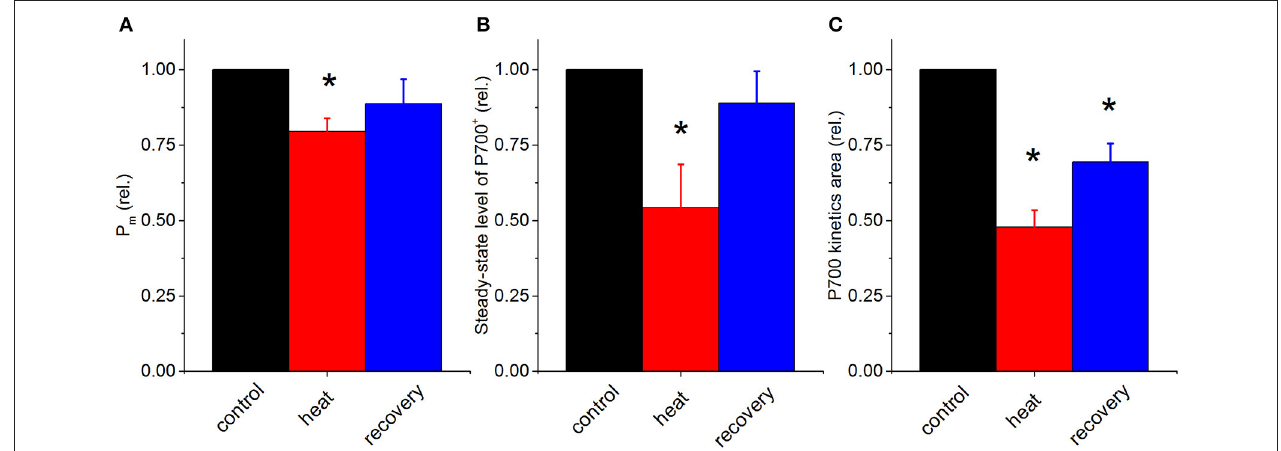
FIGURE 2 | Relative changes in P700 parameters in the coral P. decussata over the course of heat treatment and recovery period. P m (A) , initial steady-state level of P700 + (B) , and the values of P700 kinetics area (“PSII area”) (C) ; control, black column; heat treatment, red column and recovery, blue column. Signals were recorded on the same samples under the same temperature treatment as described in Figure 1 . Statistically significant differences of parameters between control and treatment ( p < 0.05) are denoted with asterisks. Error bars are standard errors of mean (SEM), n = 3.